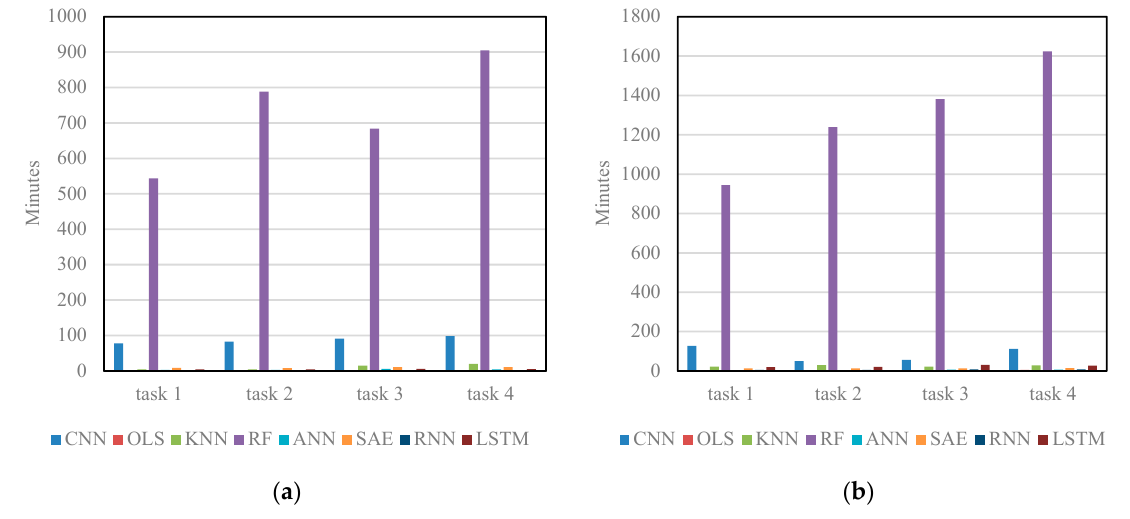
Figure 7. Training time of different algorithms: ( a ) training time on Network 1; and ( b ) training time on Network 2.